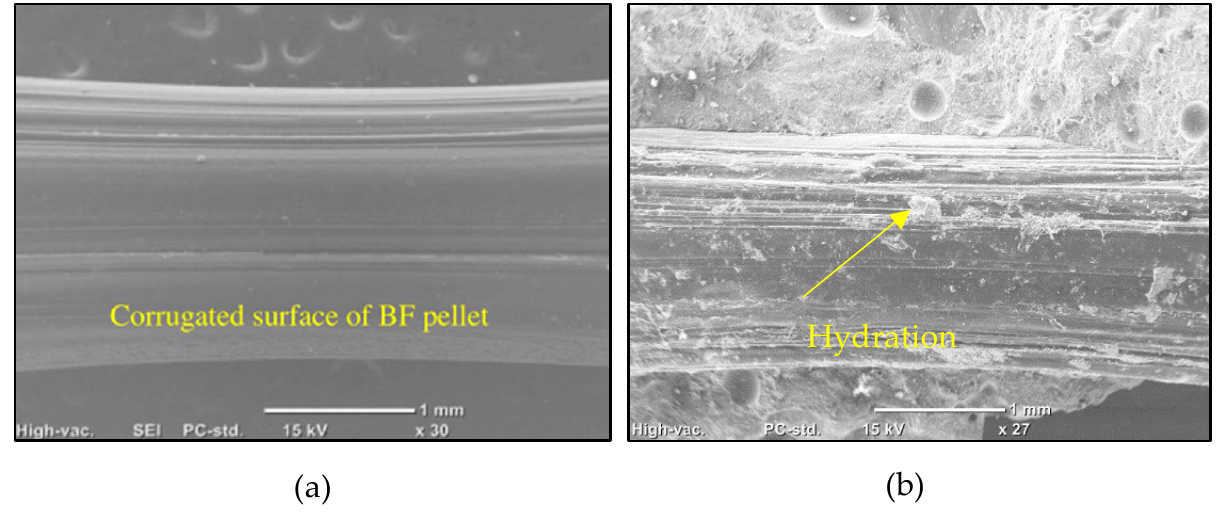
Figure 6. SEM images for ( a ) the morphology of the BF pellet surface; ( b ) hydration products in BF pellet grooves. To assess the effectiveness of incorporating the FRCC as a layer, not over the whole cross-section, on improving the post-cracking behaviour, additional sets of prisms were cast and tested following the guidelines of ASTM C1609